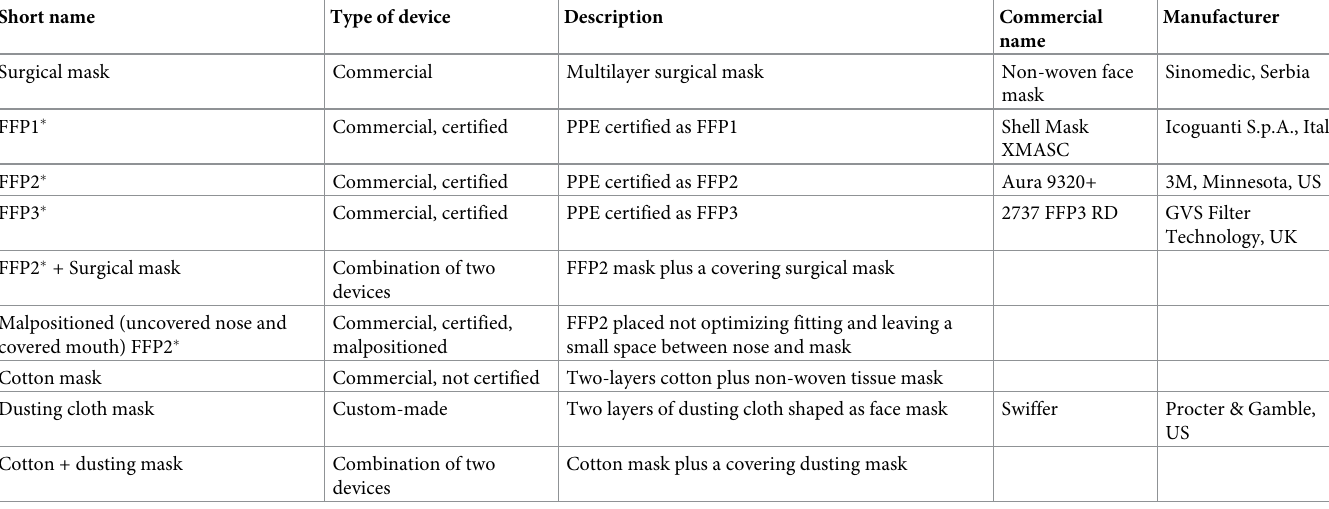
Table 1. Detailed description of the different types of tested devices, according to their certification, commercial name and